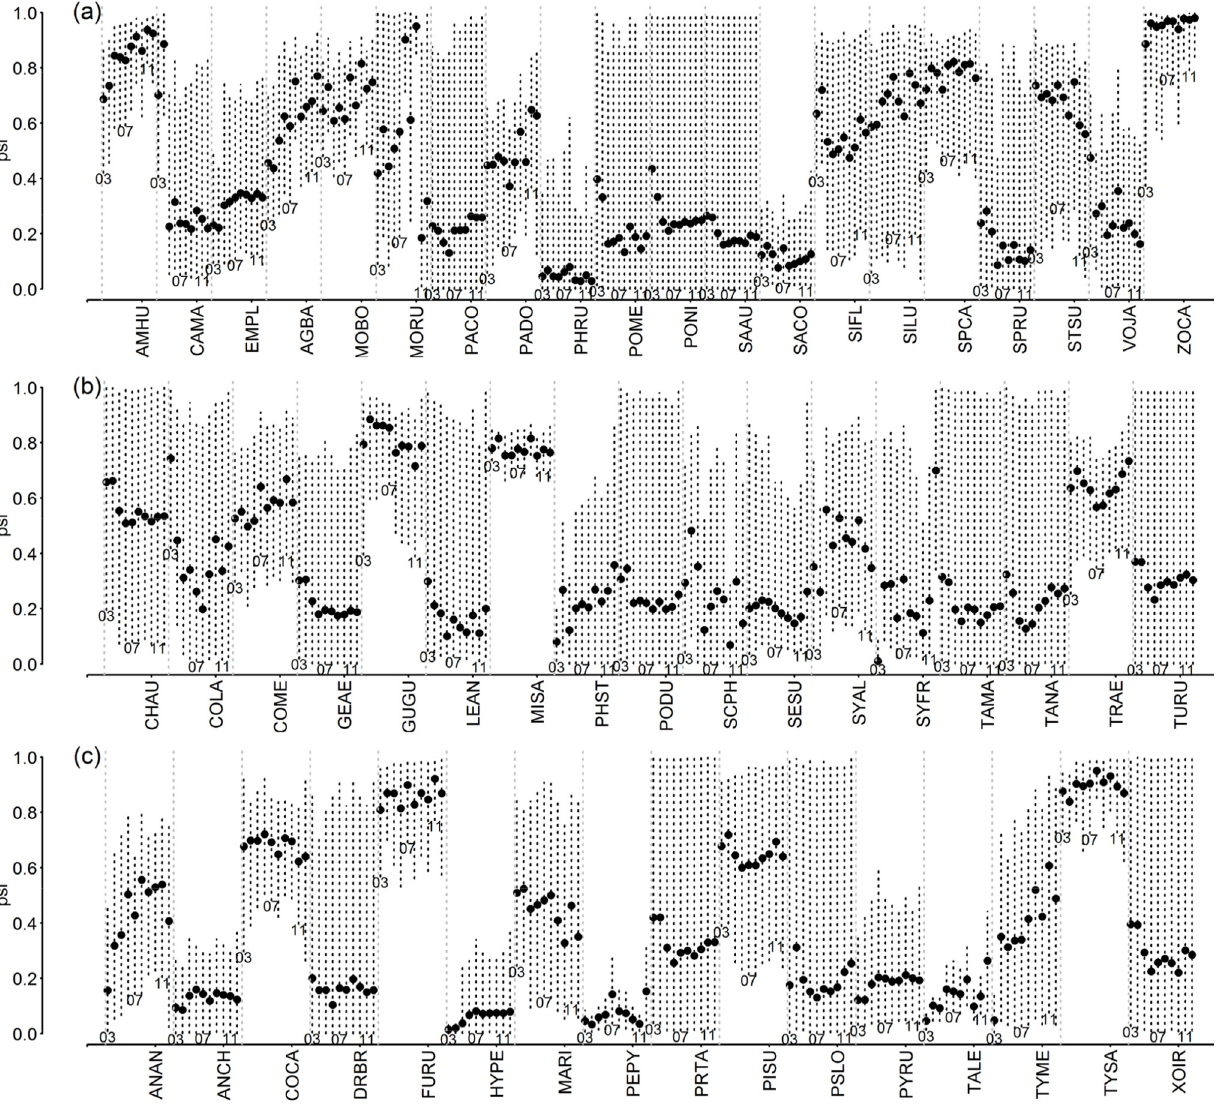
Fig 4. Mean occupancy ( ^ ψ ± SD, 95% BCI) for the complete study area during 2003 – 2012, in the regional bird monitoring program in Argentina for mostly Passeriformes species. (a) Granivores; (b) insectivores mostly associated with folliage; (c) other insectivores. For details of species names and guilds, see S1